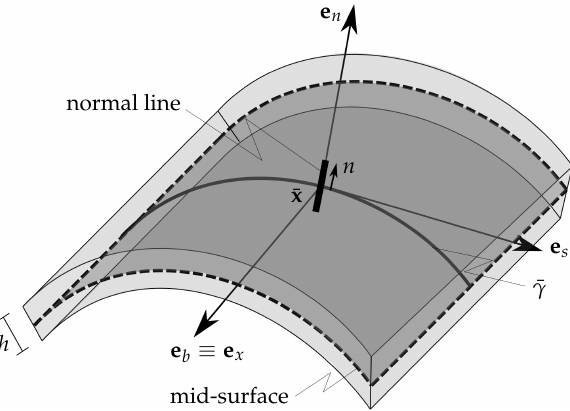
Figure 2. Local sketch of the singly curved thin